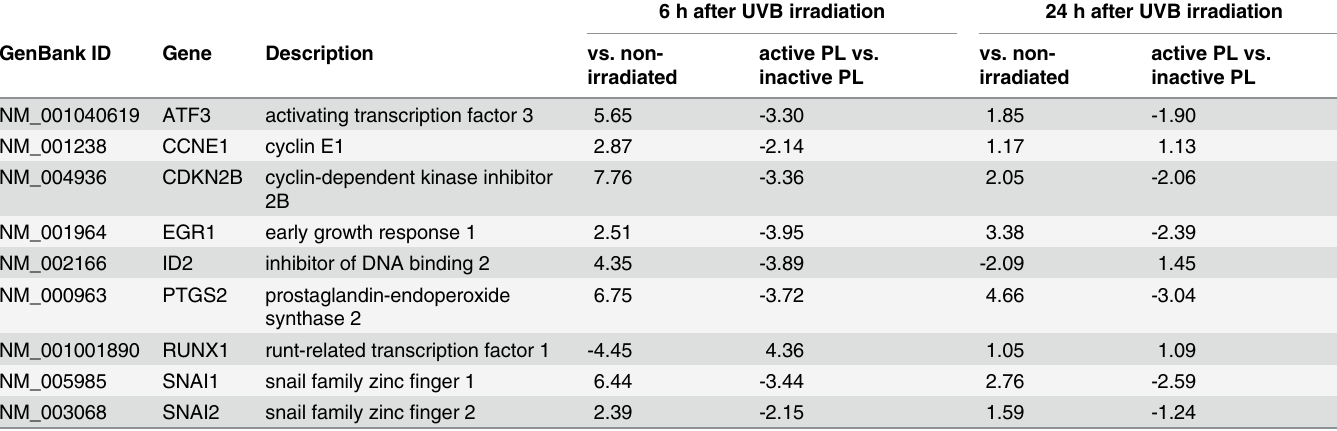
Table 1. Summarized fold change values by microarray results of the selected 9 CPD-dependent genes. 6 h after UVB irradiation 24 h after UVB irradiation